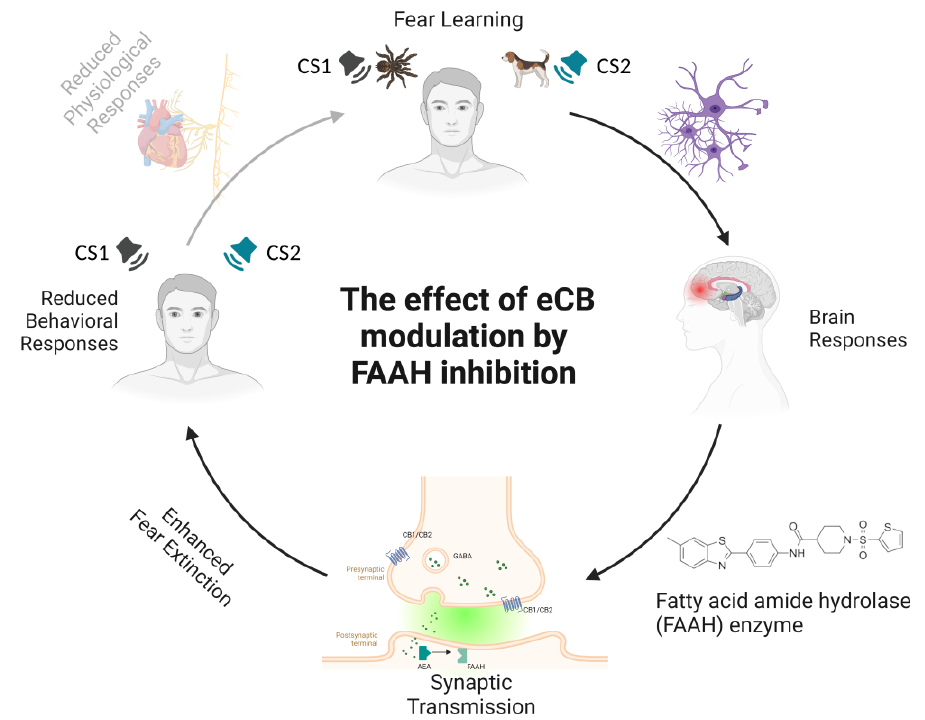
Figure 3. Schematic representation of the effects of anandamide (AEA) elevation on fear extinc- tion learning. The acquisition of conditioned fear is achieved by presenting a stimulus paired with an aversive unconditioned event. As a result of this pairing, fear learning takes place, manifesting as the development of conditioned responses to the conditioned stimulus. The modulation of fear learning by the endocannabinoid (eCB) system occurs via cannabinoid receptor type 1 (CB1) signaling. The endocannabinoid transporter (ECT) mediates eCB synaptic re-uptake. The most important eCB, anandamide (AEA), acts as a low-efficacy agonist at CB1 receptors and is released after postsynaptic synthesis to retroactively bind to endocannabinoid receptors CB1 and CB2 at the presynaptic site. AEA is preferentially metabolized by fatty acid amide hydrolase (FAAH) into arachidonic acid and ethanolamine. Indeed, the inhibition of FAAH activity maintains AEA signaling during fear learning, favoring top-down cortical control of the amygdala and resulting in emotion regulation. Specific effects of the local inhibition of AEA in humans are reflected by an increased firing rate in prefrontal brain regions that facilitates prefrontal–amygdala connectivity through alterations in synaptic transmission. FAAH activity is expressed in enhanced fear extinction and selective attenuation of autonomic stress responses (i.e., reduced physiological and behavioral responses to fear